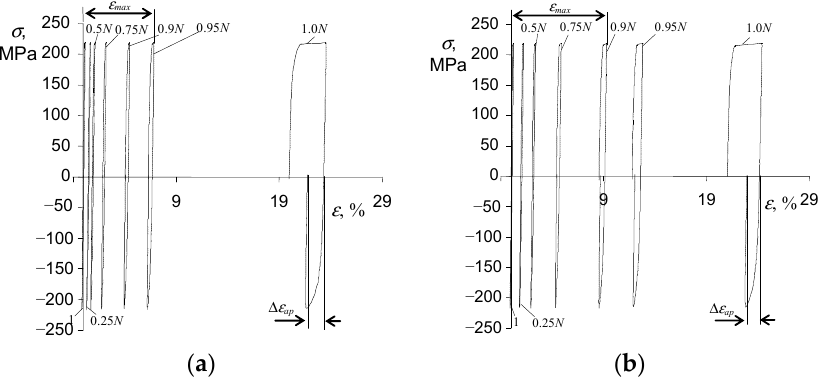
Figure 8. Hysteresis loops in creep-fatigue conditions for σ a = 219 MPa, and ( a ) τ = 5 s, ( b ) τ = 30 s.